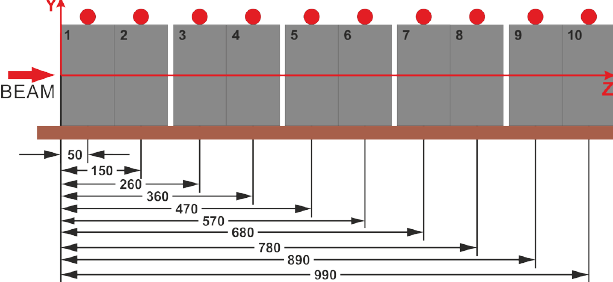
Figure 1. Scheme of the Carbon target with locations of the experimental